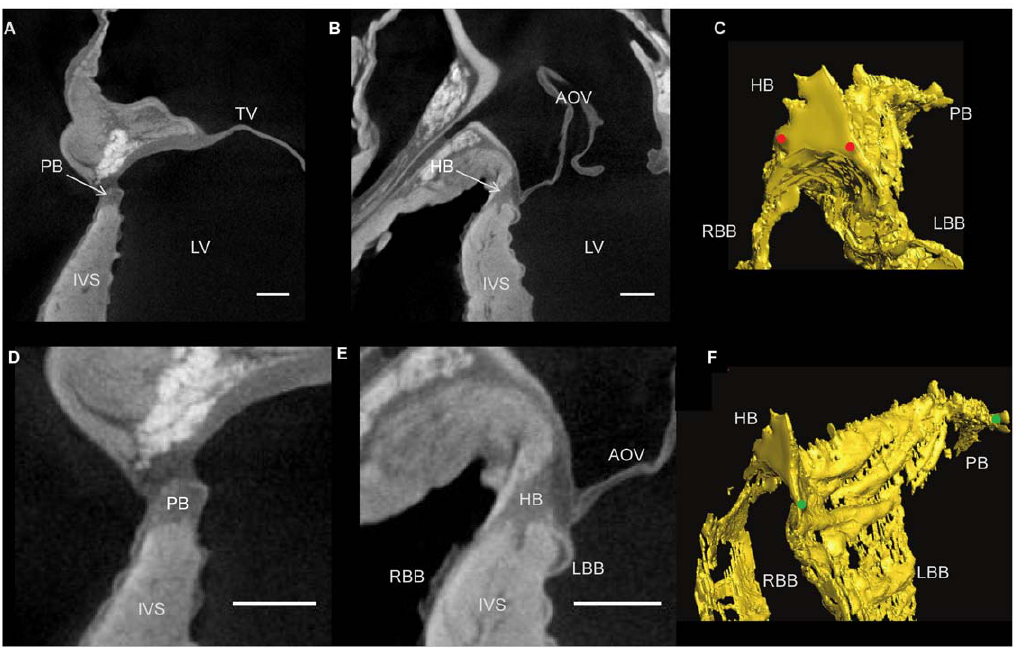
Figure 5. 3-dimensional representation of the Purkinje Network. 3 rabbit hearts stained with 7.5% I 2 KI for 3 days (A-C Rabbit Heart 1) and 3.75% I 2 KI for 5 days (D-F Rabbit Heart 2, g-i Rabbit heart 3). Volume renderings viewed from base to apex (A,D,G), with corresponding segmented 3D surfaces in transverse (B,E,H) and longitudinal orientation (C,F,I). Volumes of segmented data- 4.2 mm 3 , 5.5 mm 3 , 15.8 mm 3 respectively. Coloured dots represent Purkinje network maximum widths- distance between green dots- 13.5 mm, red dots- 17.1 mm, blue dots- 14.4 mm. IVS- interventricular septum, PM- papillary muscle. doi:10.1371/journal.pone.0035299.g005 projects anteriorly before taken a more vertical route down the of branches running on the endocardial surface towards the base IVS. The left ventricular Purkinje network in rat is localised to the with no cross luminal branching. In contrast the left ventricular apical region, creating a scoop-like appearence, with the majority Purkinje network of the rabbit appears as a web-like structure